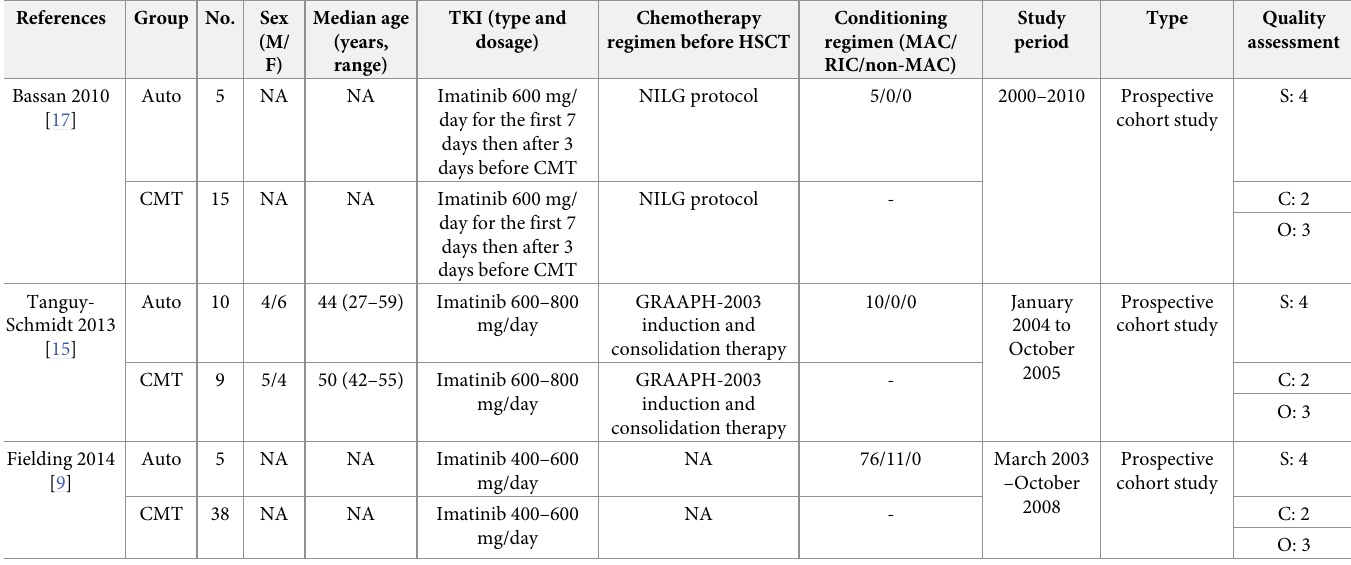
Table 3. Characteristics and participants of studies that compare autologous HSCT to chemotherapy alone.